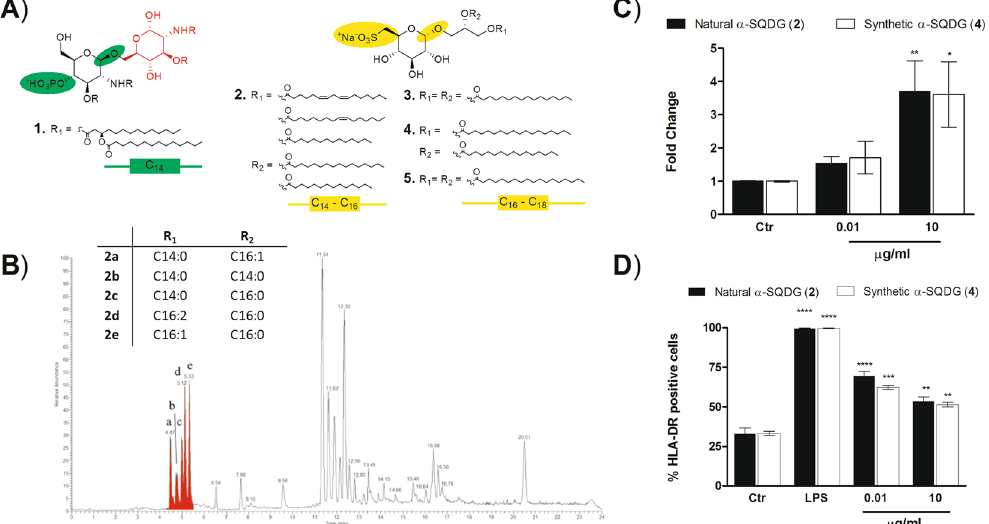
Figure 1. Chemical structure and DC activation of natural sulfoquinovosides ( α -SQDG) from marine diatoms. ( A ) Structures of DC agonists: monophosphoryl lipid A (MPLA, 1 ) (reference compound), natural α -SQDG ( 2 ) and synthetic ( 3 - 5 ) α -SQDG. Colors underline the chemical differences in type and position of the anionic function, configuration of the anomeric carbon, second sugar residue and fatty acid acyl chain between MPLA ( 1 ) and α -SQDG ( 2 - 5 ); ( B ) LC-MS profile of active α -SQDG ( 2 ) in the extract of the marine diatom Thalassiosira weissflogii . The insert reports the type and distribution of fatty acids bound to the sulfoquinovosyl glycerol residue; ( C ) expression of IL-12 (mean/standard deviation) and ( D ) expression of HLA-DR by MoDCs stimulated with natural and synthetic analogs of α -SQDG at 10 ng/mL and 10 µ g/mL. Results (mean + / − standard deviation) are reported as percentage of positive cells (marker expression value over 10 4 ) out of the total DC population. LPS was used as positive control. Asterisks indicate significant differences from the cells treated only with vehicle (control, Ctr) at a 95% (P < 0.05) confidence level, as determined using two-way ANOVA